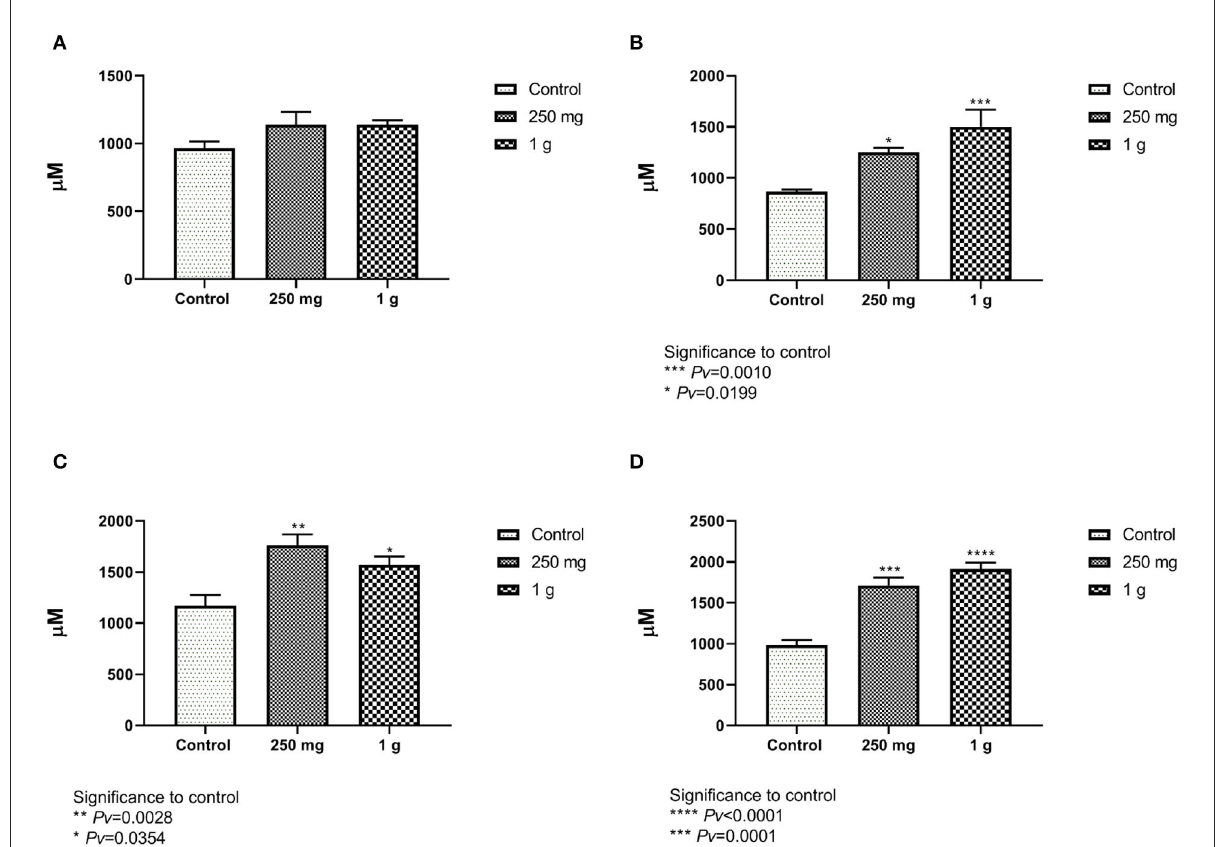
FIGURE7 (A, B) The length of the villi from the ileum compared with the beta-glucans treatment groups to the control. (A) The females and figure. (B) The males (n = 5 per group). (C, D) The length of the villi from the jejunum compared with the beta-glucans treatment groups to the control. (C) Represent the females, and (D) for the males (n = 5 per